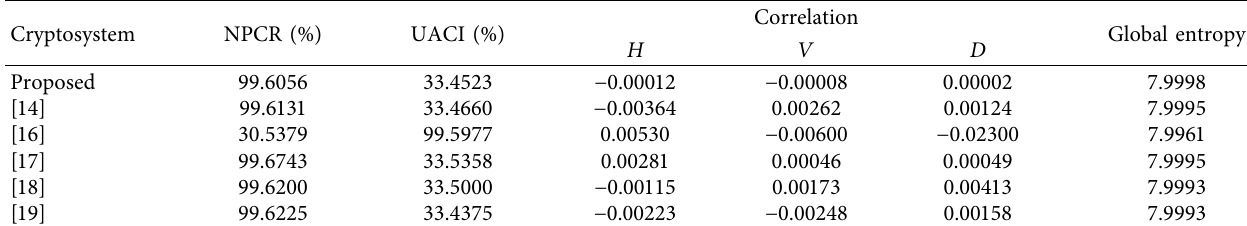
Table 8: Comparison of proposed cryptosystem alongside other chaos-based multi-image cryptosystems.